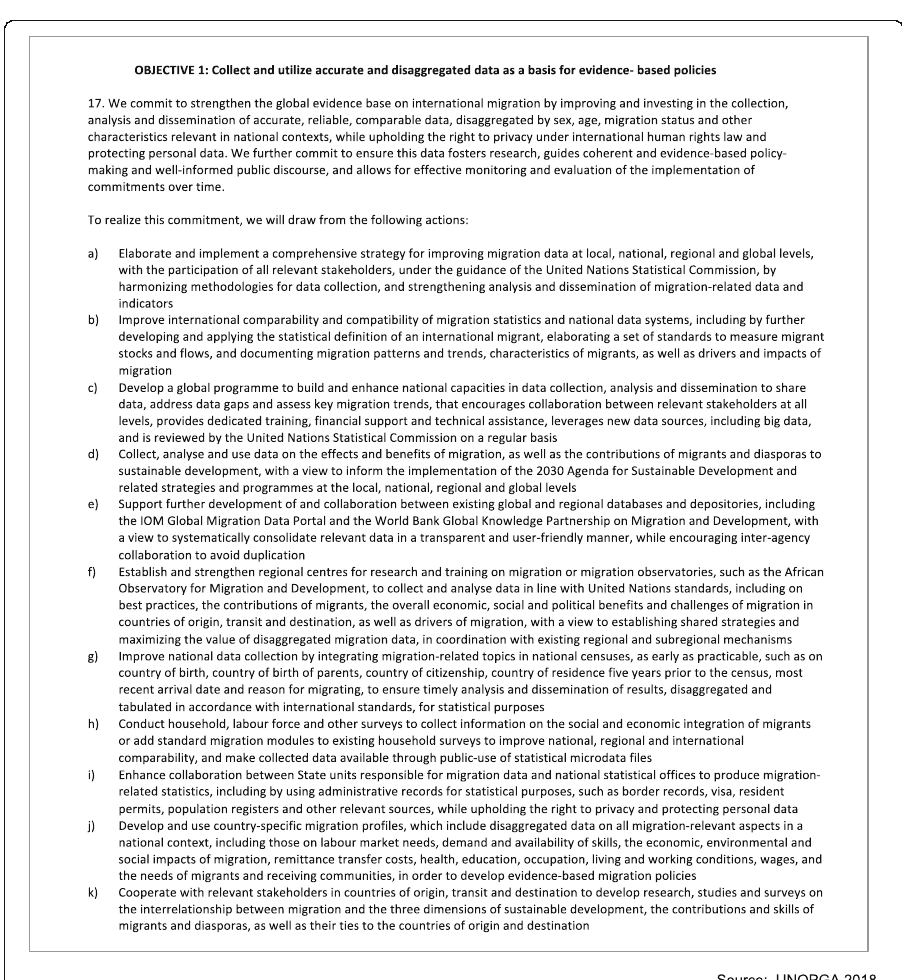
Fig. 2 Global Compact for Safe, Orderly and Regular Migration Final Draft, Objective